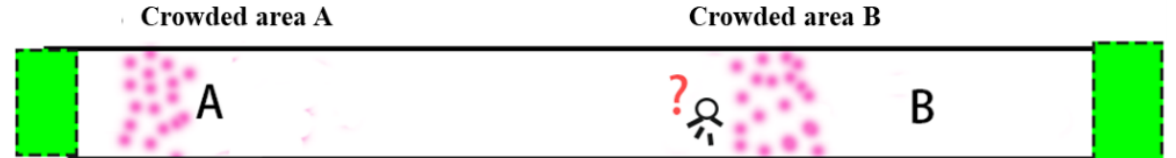
Figure 4. The unbalanced crowded zone.